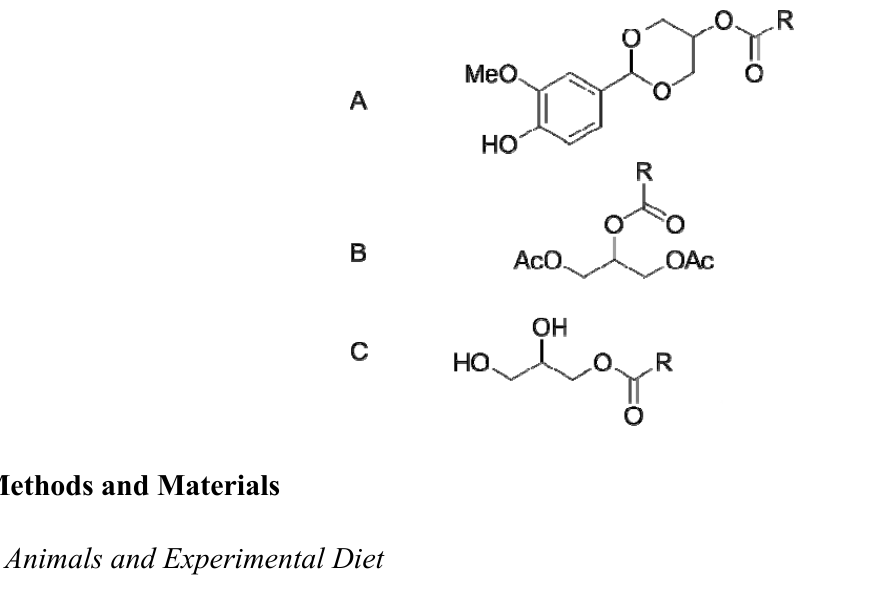
Figure 1. Chemical structures and the name of the compounds tested in the present study: ( A ) Vanillin acetal of sn -2-MAG; ( B ) 1,3-diacetyl-2-MAG; ( C ) sn -1(3)-MAG; R indicates a fatty acid as eicosapentaenoic (EPA) or docosahexaenoic acid